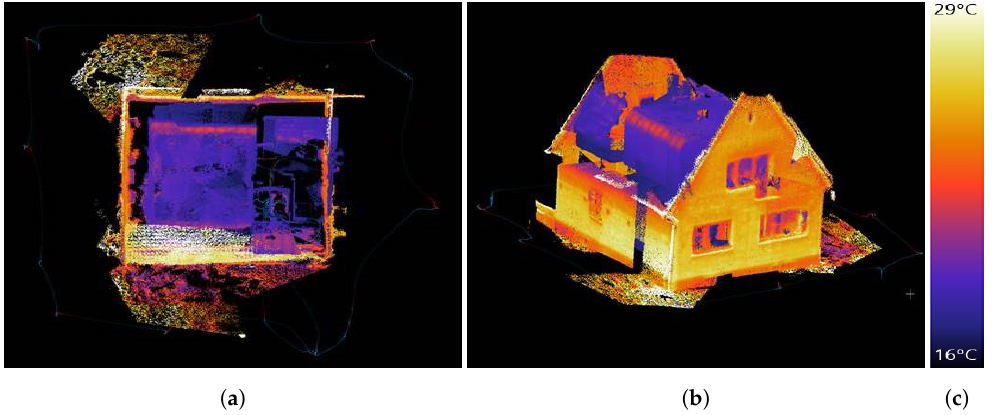
Figure 9. Complete IR mapped point cloud combining IPS and thermal camera data: ( a ) top view; ( b ) side view; ( c ) color bar with temperature